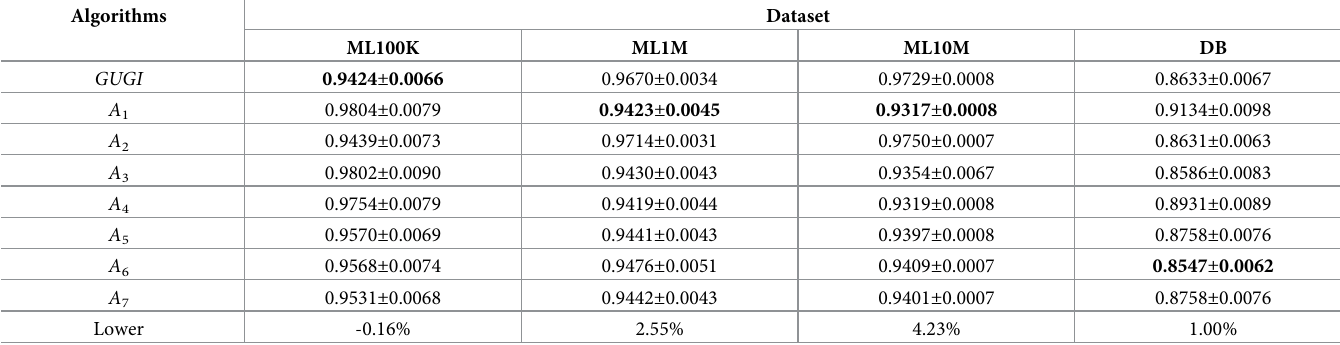
Table 6. RMSE comparison under M-distance